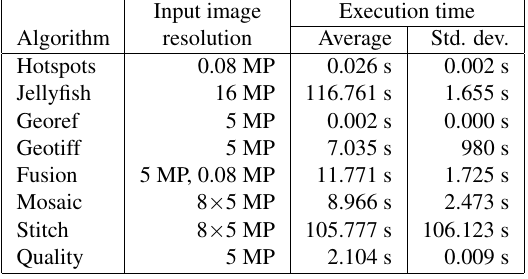
Table 2: Input data sets resolution and sequential execution